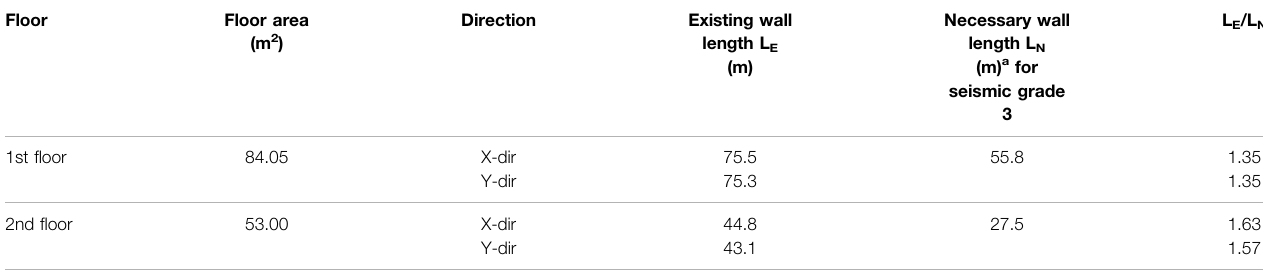
TABLE 1 | Existing and necessary wall lengths and their